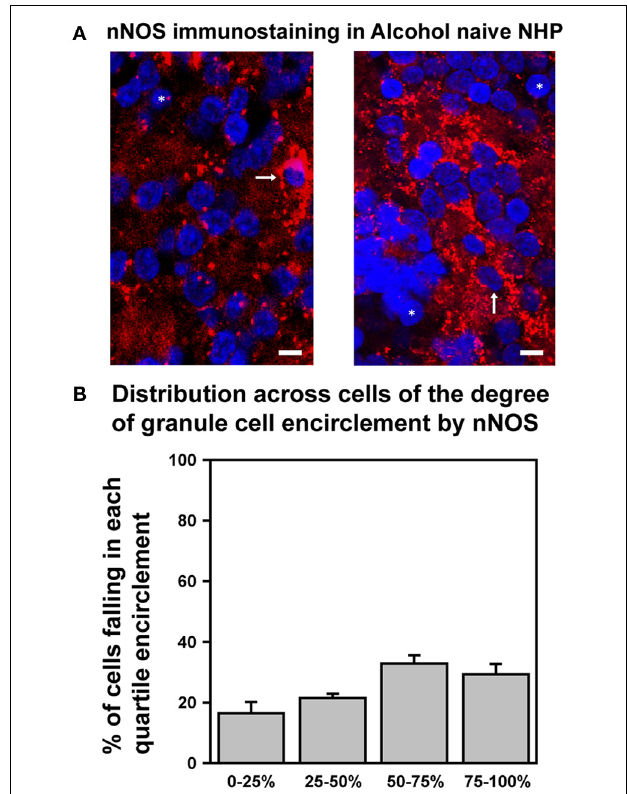
FIGURE 6 | Differential expression of nNOS mirrors differences in EtOH-induced potentiation of GC GABA A R transmission. (A) Confocally acquired images of immunocytochemistry for nNOS (red) and nuclear stain Hoechst (blue) in the granule cell layer of NHP cerebellum. Arrows point to examples of GC somas completely surrounded by nNOS signal, and ∗ indicate examples of GC somas completely devoid of nNOS encirclement. (B) Plot of mean percent encirclement of GC soma/nuclei (determined as described in Kaplan et al. (2013); n = 2 , 569 GCs from six